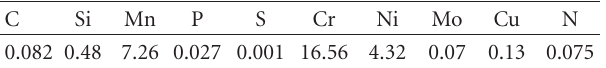
Table 1: Chemical composition (% by weight a ) of the tested austenitic low-nickel